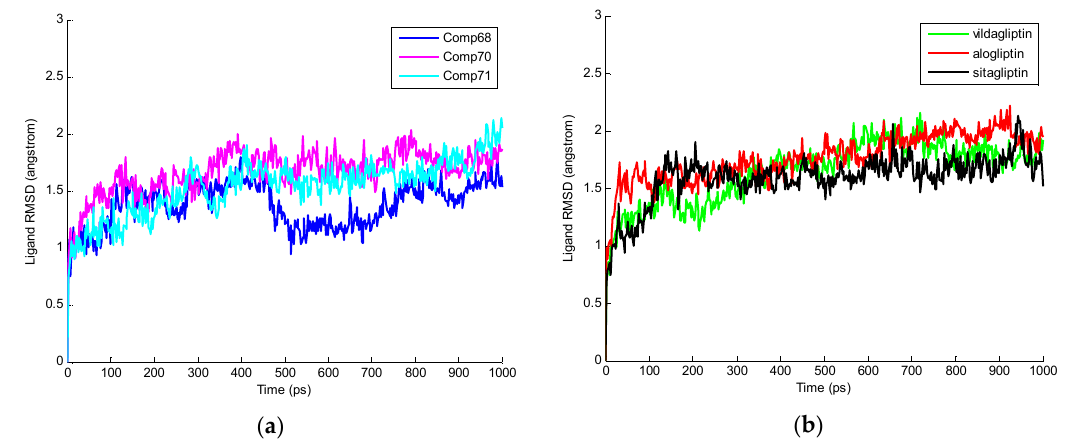
Figure 7. RMSD values of ligands through MD simulation at different time levels. ( a ) RMSD values of Comp68, Comp70, and Comp71 are present as blue, magenta, and cyan, respectively; ( b ) RMSD values of Vildagliptin, Alogliptin, and Sitagliptin are shown as green, red, and black, respectively. Table 4. RMSD values of protein ligand complexes and individual ligands following MD simulation. Average RMSD Values for Protein-Ligand Complexes Average RMSD Values for Ligands 2P8S_Comp68 (1.44 ± 0.13 Å)